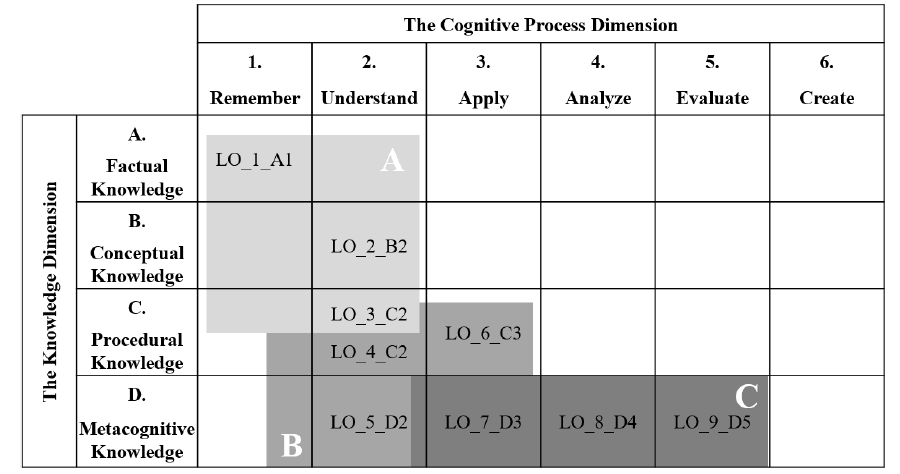
Fig. 1. Classification of FSTG’s learning objectives according to Bloom’s Taxonomy